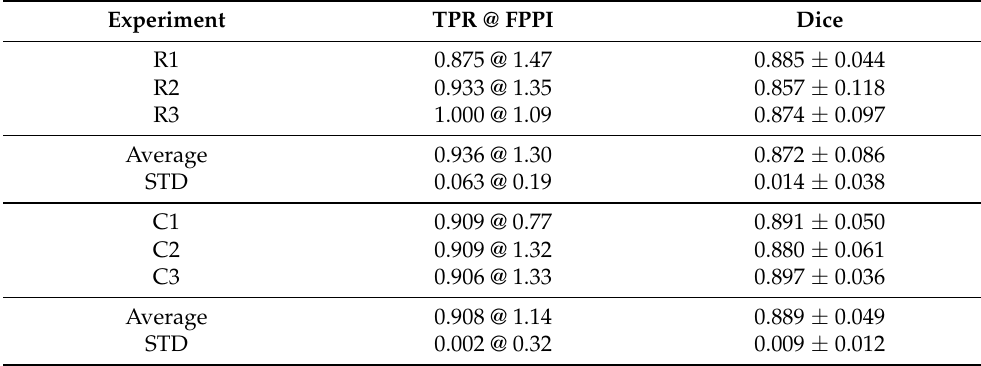
Table 1. Comparison of TPR and Dice metrics between experiments. Experiments R1, R2 and R3 use a random split of the images. Experiments C1, C2 and C3 use case-wise partition of the images. Experiment TPR @ FPPI Dice R1 0.875 @ 1.47 0.885 ± 0.044 R2 0.933 @ 1.35 Average 0.936 @